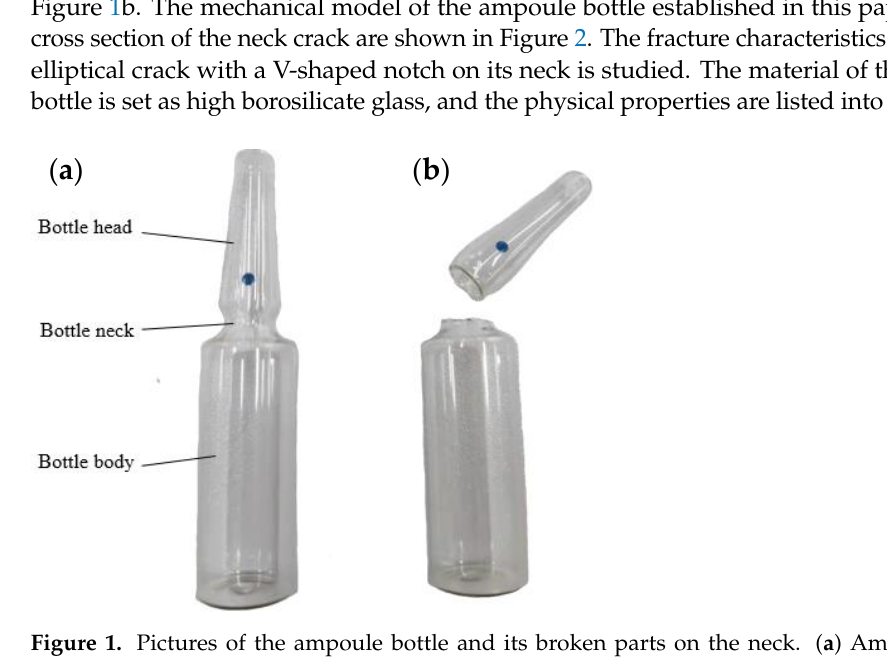
Figure 2. Mechanical model of an ampoule bottle with a V-shaped notch and semi-elliptical crack. ( a ) Schematic of loads and constraints. ( b ) Schematic of crack cross-section. The neck of the ampoule bottle can be broken when the loads are applied to the bottle head. The restraint and load conditions (see Figure 2) are set as follows: fully restrained at the bottom of the ampoule bottle, and an upward tensile stress σ on the bottle head. Simultaneously, a bending moment W is applied as a simulated boundary condition. The parameters of the semi-elliptical crack for the FEM calculation include: (1) the outer radius of the neck R , (2) the inner radius r , (3) the length of short semi-axis of the ellipse a , (4) the length of long semi-axis c , and (5) the crack located in the middle of the neck of the am- poule bottle. The maximum angle of the crack tip on both sides from the deepest point of the crack is 𝜃 𝑚𝑎𝑥 .